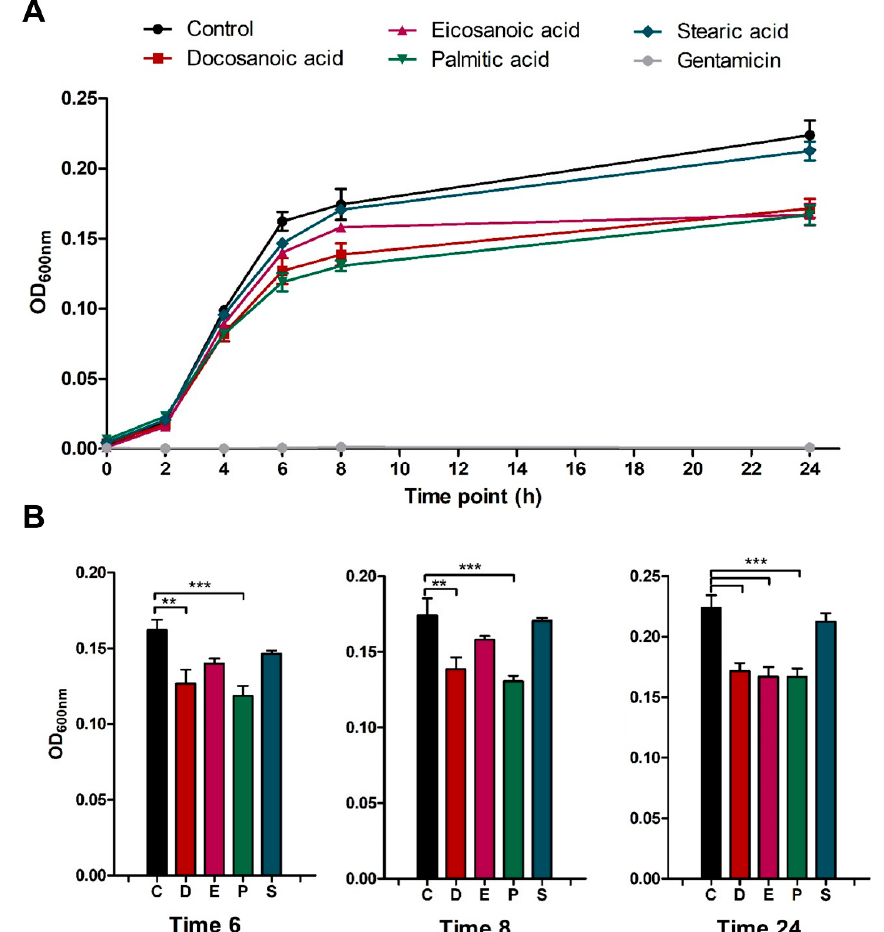
Figure 4. Eicosanoic, docosanoic and palmitic acid restricts in vitro USA300 growth in Nutrient Broth medium. ( A ) In vitro bacterial growth curves in Nutrient Broth and supplemented with DMSO (control), one fatty acid (30 µM) and gentamicin (100 µg/mL) were evaluated by measuring the absorbance at 2, 4, 6, 8 and 24 h. ( B ) In vitro bacterial growth at 6, 8 and 24 h in the presence of DMSO ( C ), docosanoic acid ( D ), eicosanoic acid ( E ), palmitic acid ( P ) or stearic acid ( S ). Data are expressed as means ± SE of three independent experiments performed in duplicates. One-way ANOVA and post hoc Tukey’s multiple comparison tests were performed to assess statistically significance across treatments. p -value ≤ 0.01 (**); ≤ 0.001 (***).